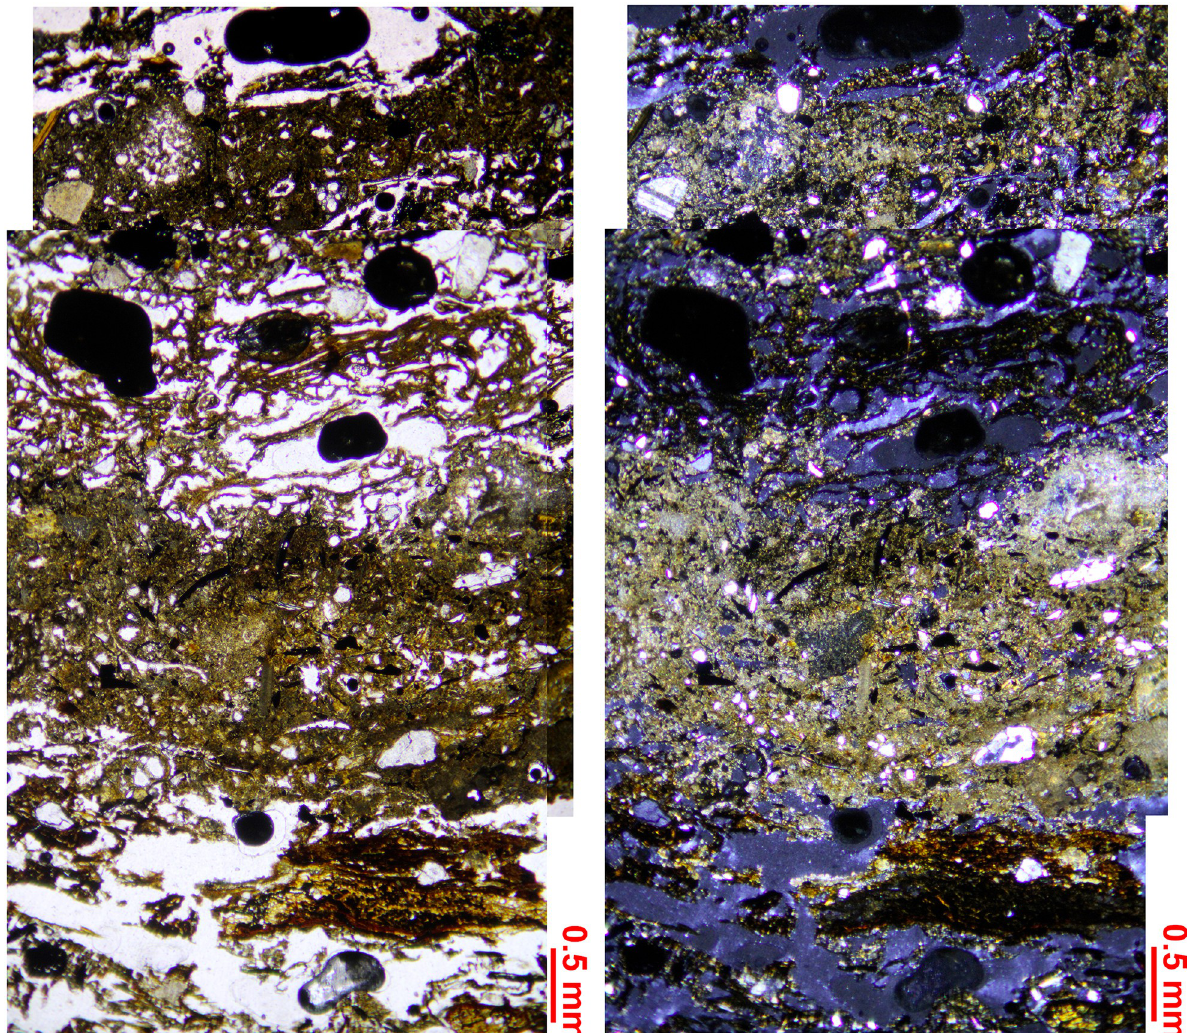
Fig 10. Typical alternating sequence of ash (SMT 1, SMT 1b) and trampled herbivore dung (SMT 2b), recurring several times in both studied structures. Structure E, thin section OPP 82–3. PPL (left) and XPL